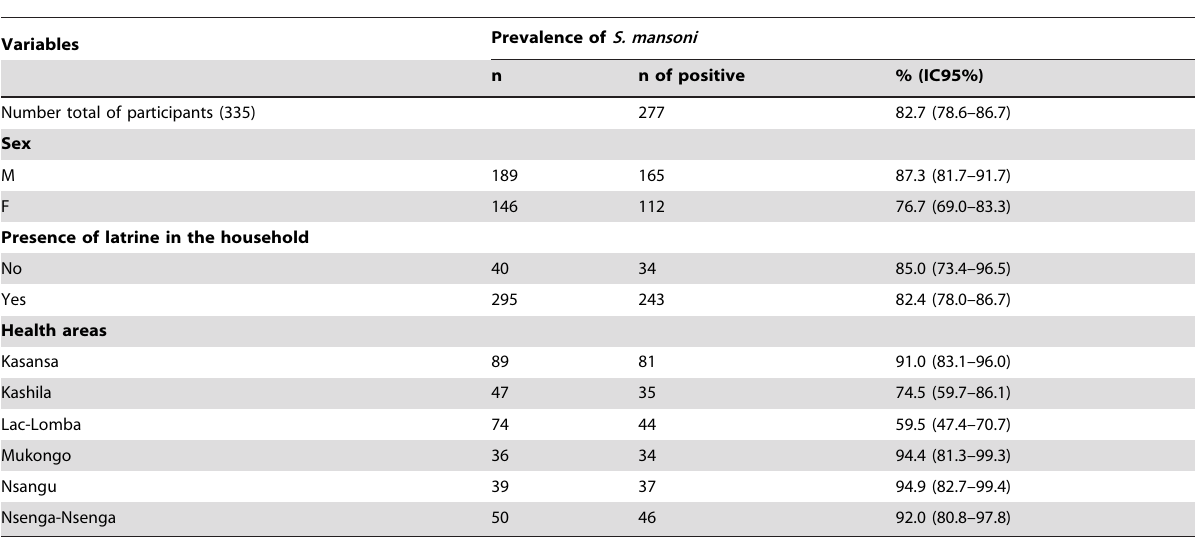
Table 1. Prevalence of S. mansoni in the six health areas of Kasansa health zone.